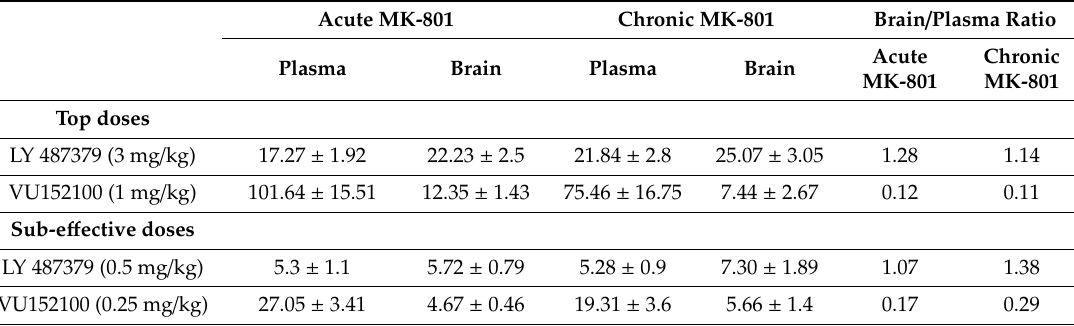
Table 1. Plasma or brain concentration (ng / mL) and brain penetration of the highest doses of LY487379 and VU152100 or sub-e ff ective doses of tested compounds when administered in combination (LY487379 + VU152100). Plasma and tissue were collected 30 min after administration. Investigated doses are indicated in parentheses. Data are presented as the means ± SEM. N = 8–10 / group. Brain penetration was calculated as the ratio of the amount of drug in the brain to plasma. Acute MK-801 Chronic MK-801 Brain / Plasma Ratio Acute Chronic Plasma Brain Plasma Brain MK-801